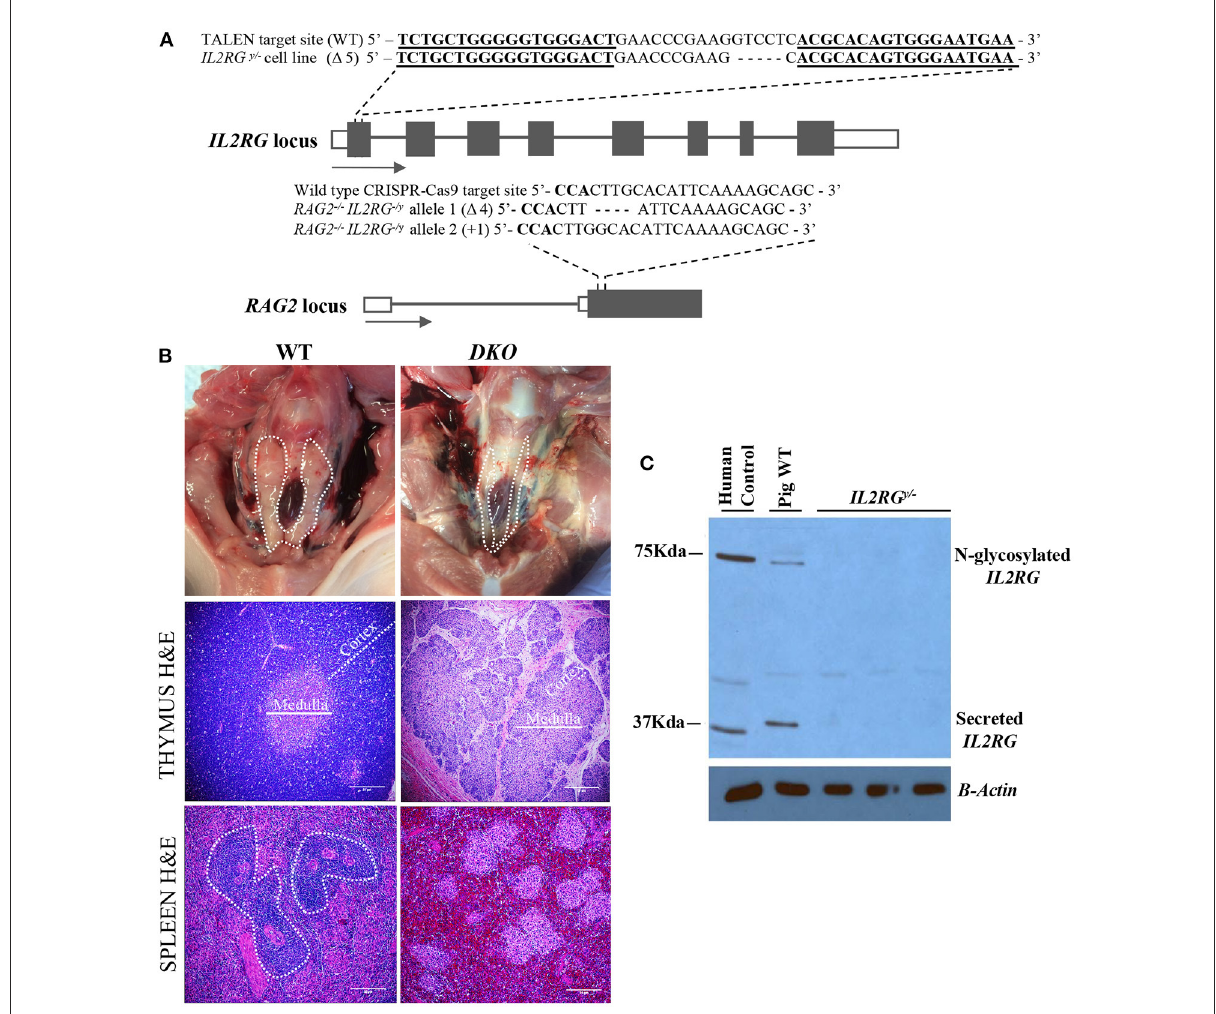
FIGURE1 Genotype and initial characterization of DKO pigs. (A) DNA sequencing of the IL2RG and RAG2 locus target regions detected from DKO pigs. Wild type (WT) sequence is shown as a reference. TALEN binding sites are represented by bold and underlined sequences, while bold sequences represent the PAM sequence. (B) Thymus (cervical region) from wild-type pigs could be easily visualized (dotted contour white line) while in age-matched DKO pigs it was nearly undetectable. H&E microscopic (20x magnification) evaluation of the DKO thymus revealed a poorly developed thymus lacking proper cortex (white dotted line), Medulla is also indicated (solid white line). The spleen of wild type age-matched pigs had visible germinal centers (dotted contour white line) while the spleen of DKO pigs did not. (C) Western blot for IL2RG using wild type (WT) and mutant pig heart tissue lysates obtained from IL2RG y / − pig fetuses. Human peripheral blood served as human positive